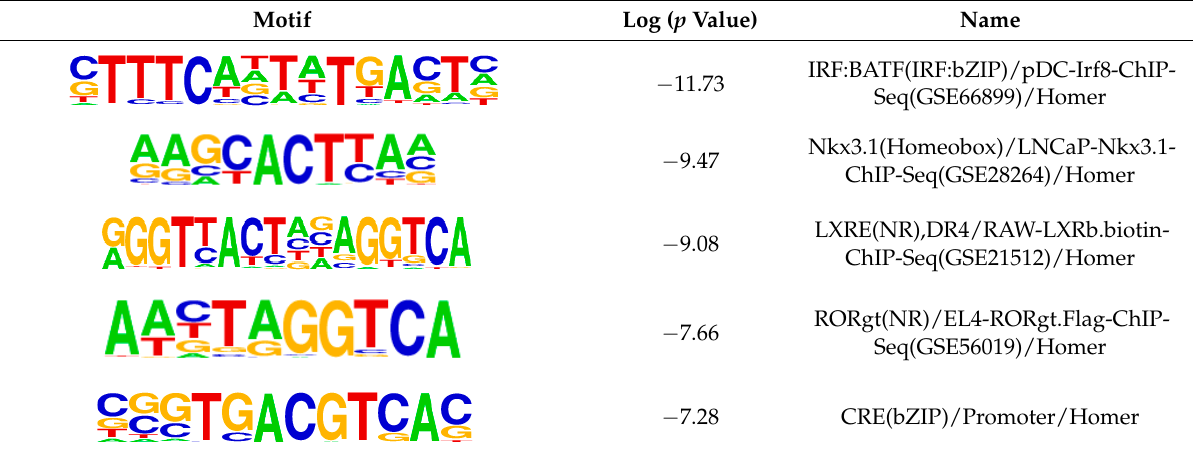
Table 4. HOMER enrichment results for top 5 known motifs in purple A. japonicus , compared with green A. japonicus .